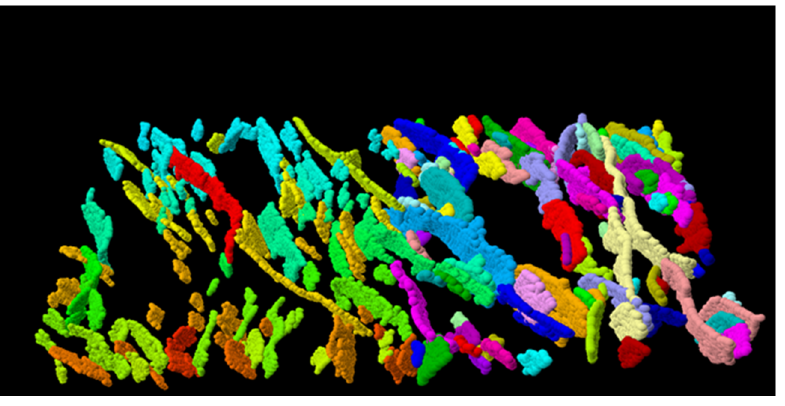
Figure 9. Fault point groups extracted individually by DBSCAN clustering from original point group data shown in Figure 8a.